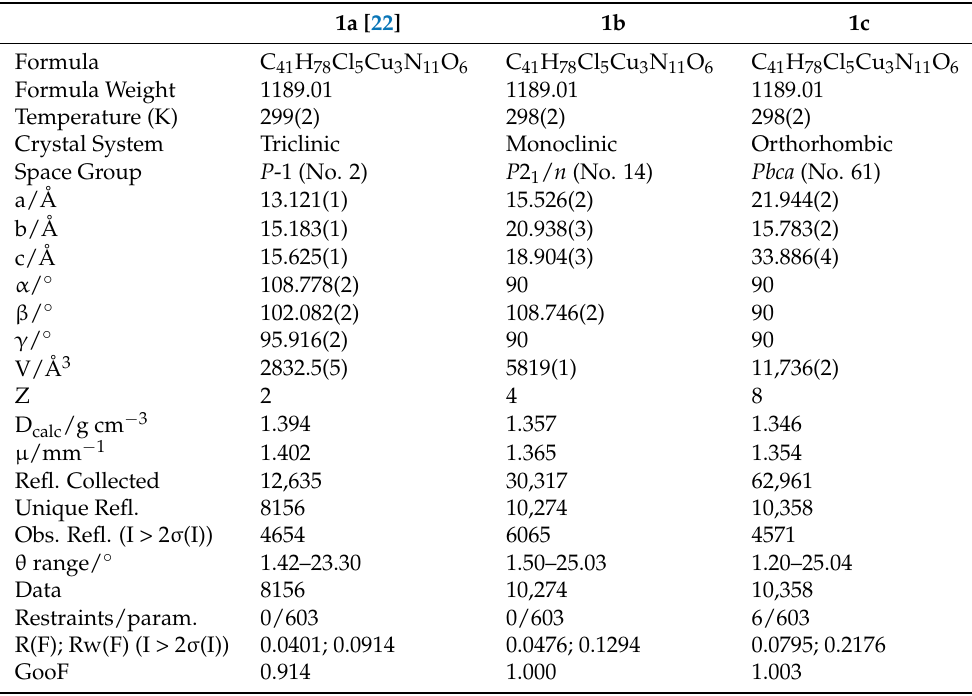
Table 1. Crystal data and structure refinement parameters for 1a – c